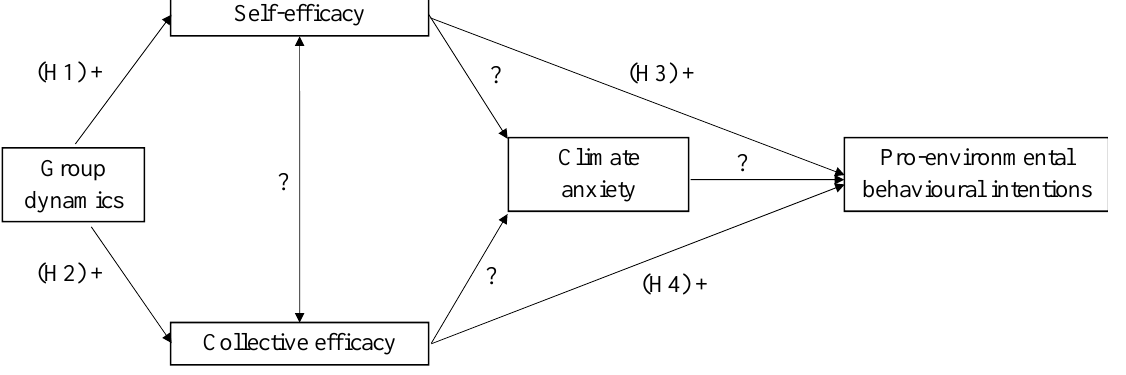
Figure 1. Summary of hypotheses and open questions.